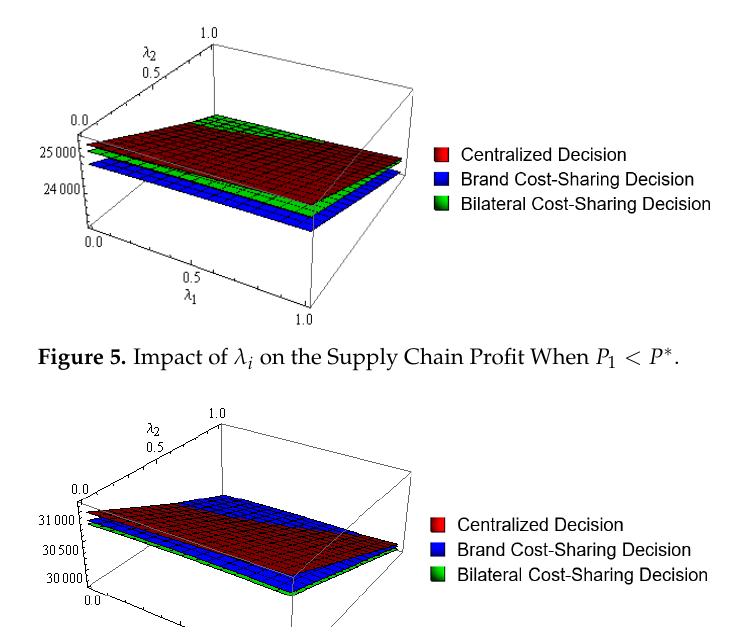
Figure 6. Impact of λ i on the Supply Chain Profit When P 1 > P ∗ .